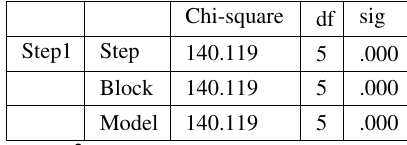
Table 6 Omnibus tests of Model Coefficients